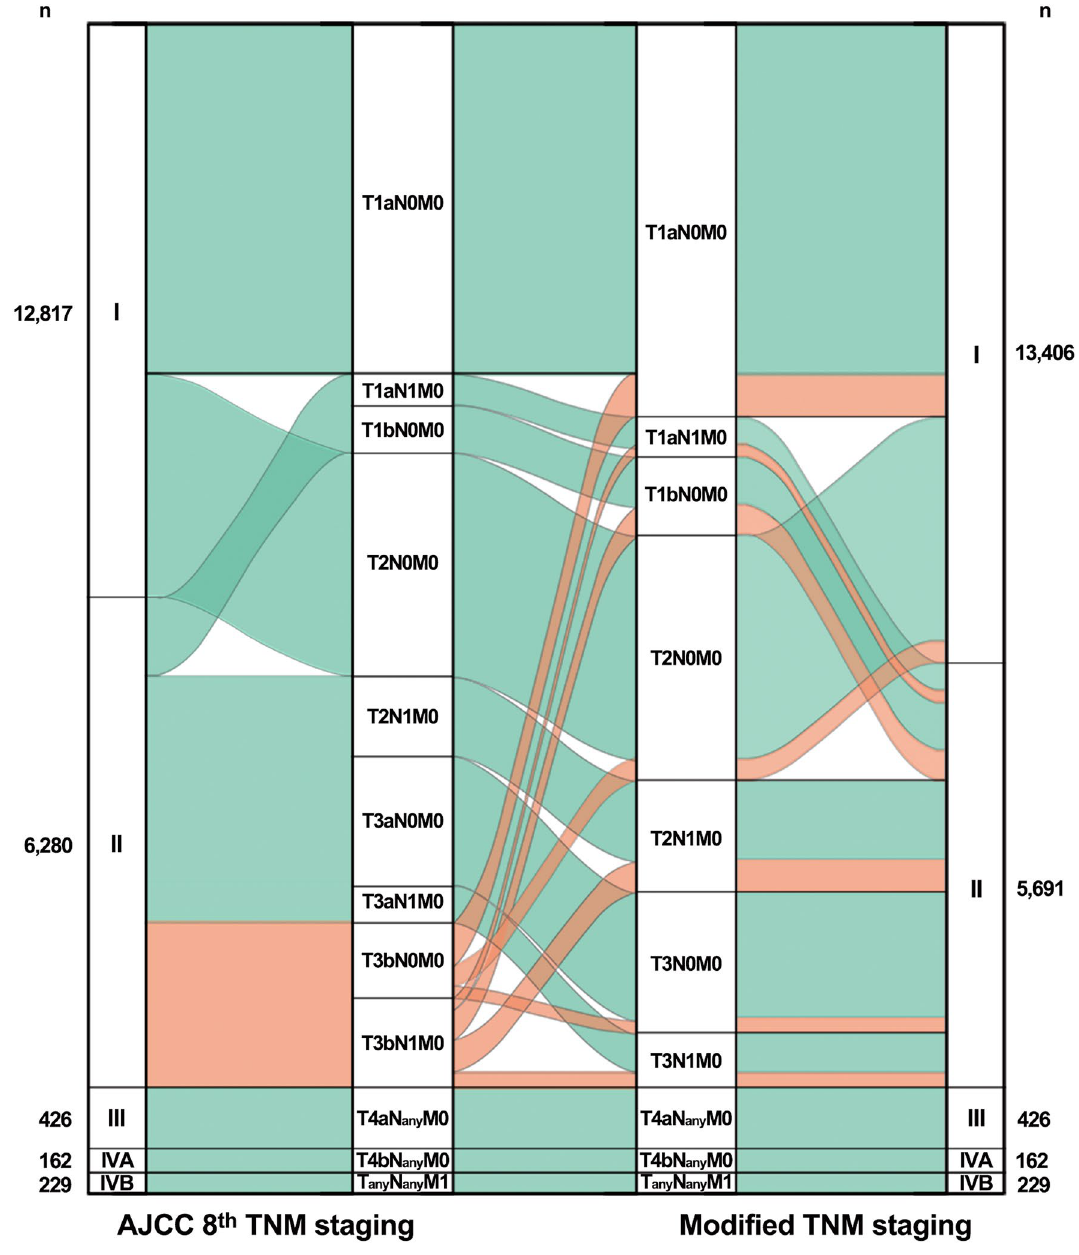
Figure 2. Restaging of the AJCC 8th TNM stages according to the modified TNM staging schema. The alluvial plot shows the reallocation flow for T stages and overall stages according to the modified TNM staging schema. Orange color indicates patients with strap muscle invasion (T3bN any M0) who were restaged according to tumor size. The number of patients in each T stage of the AJCC 8th TNM staging schema or the modified TNM staging schema are presented along the left and right